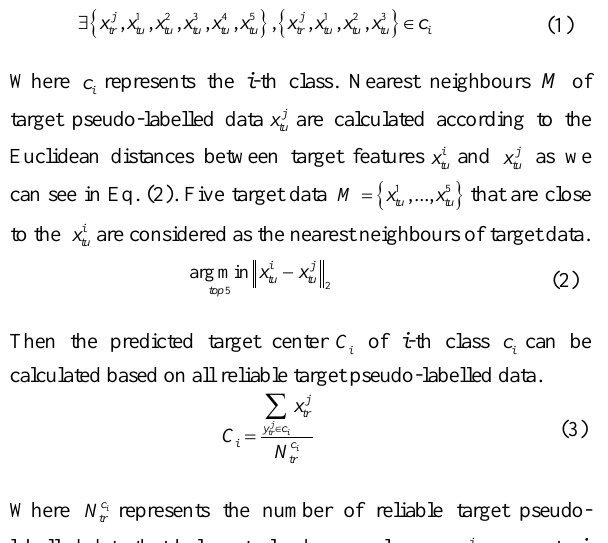
Figure 4. The definition of reliable target pseudo-labelled data.